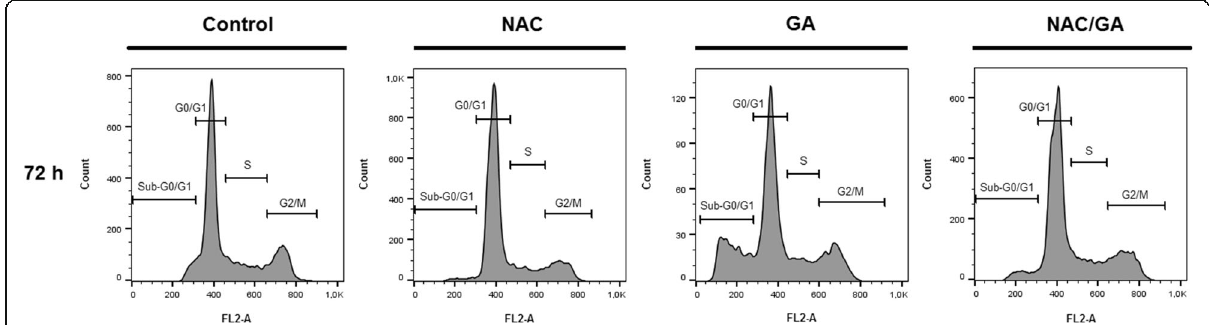
Fig. 5 Representative histograms of cell cycle distribution after GA treatment alone or after NAC pre-treatment